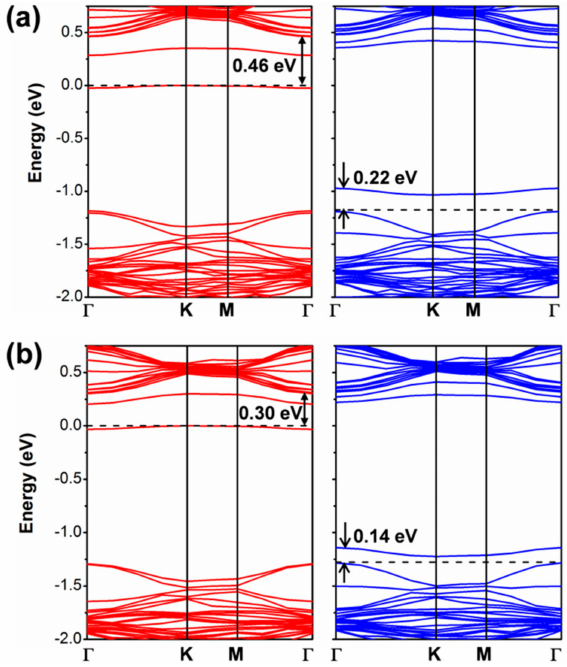
Figure 12. The band structures for the relaxed triplet exciton from PBE calculation by CRY14 ( a ) and QE ( b ). The red and blue lines represent the spin up and spin down bands, respectively. The black dashed line indicates the Fermi level and the Fermi level for spin up states is scaled to zero. Some energy difference is reported in